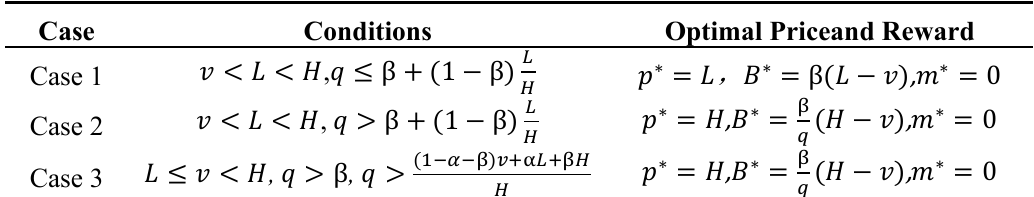
Table A1. Conditions and optimal solutions of RRP considering firm